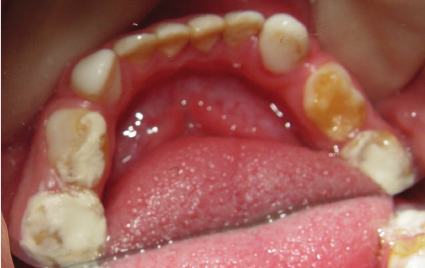
Figure 3: Glass ionomer cement on the mandibular molars in oc- clusal